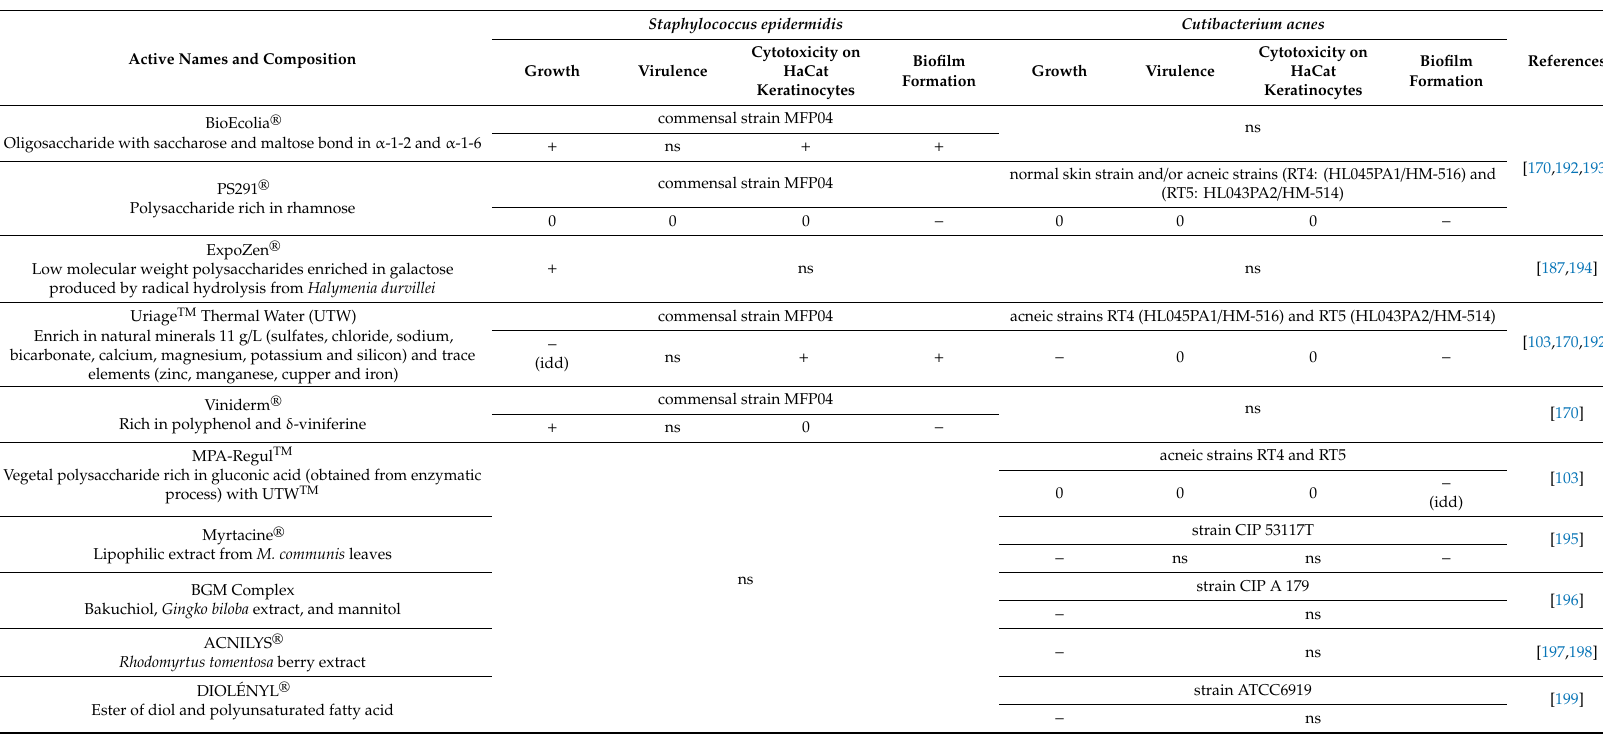
Table 1. Assessment of the e ff ect of cosmetic active ingredients on Staphylococcus epidermidis and Cutibacterium acnes (growth, virulence, cytotoxicity and biofilm